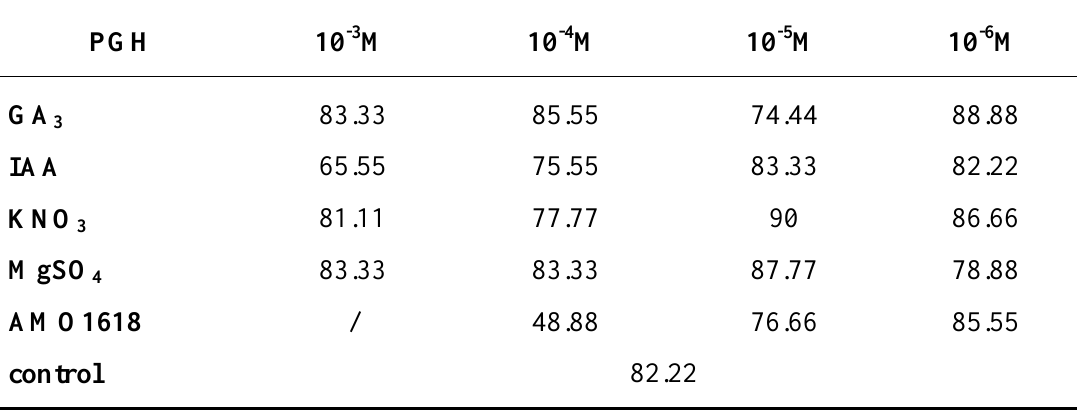
Table 1. Percent of germinated seeds of T. aestivum in different concentrations of plant growth regulators and the inhibitor AMO